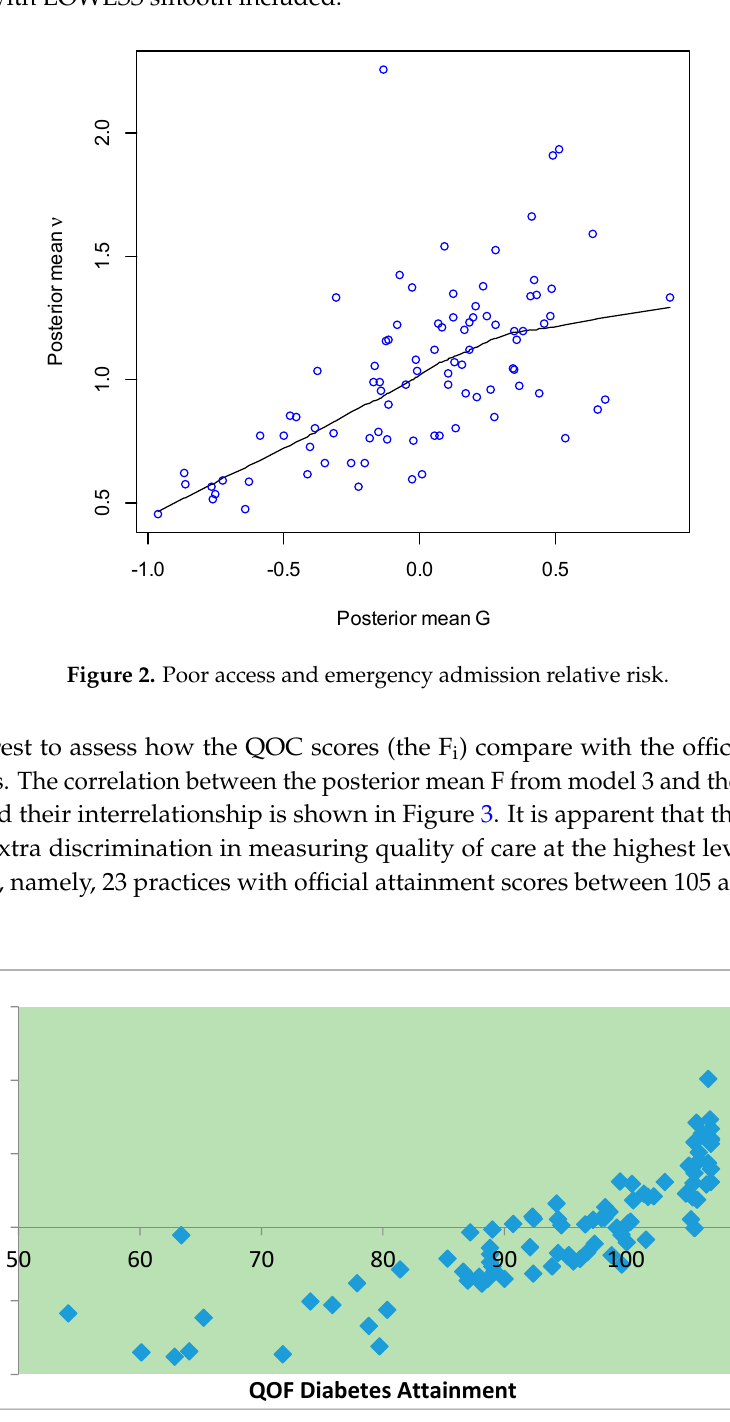
Figure 1. Quality of care and emergency admission relative risk.